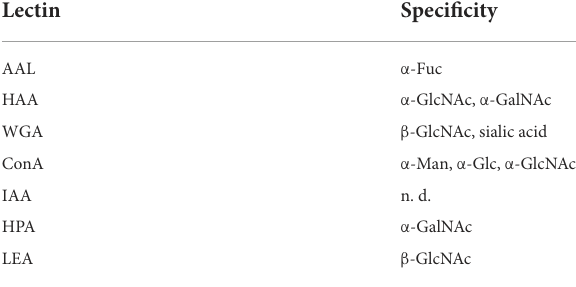
Lectinsarelistedaccordingtotheirbindingfrequency. n.d.—lectinspecificitynotdetermined.